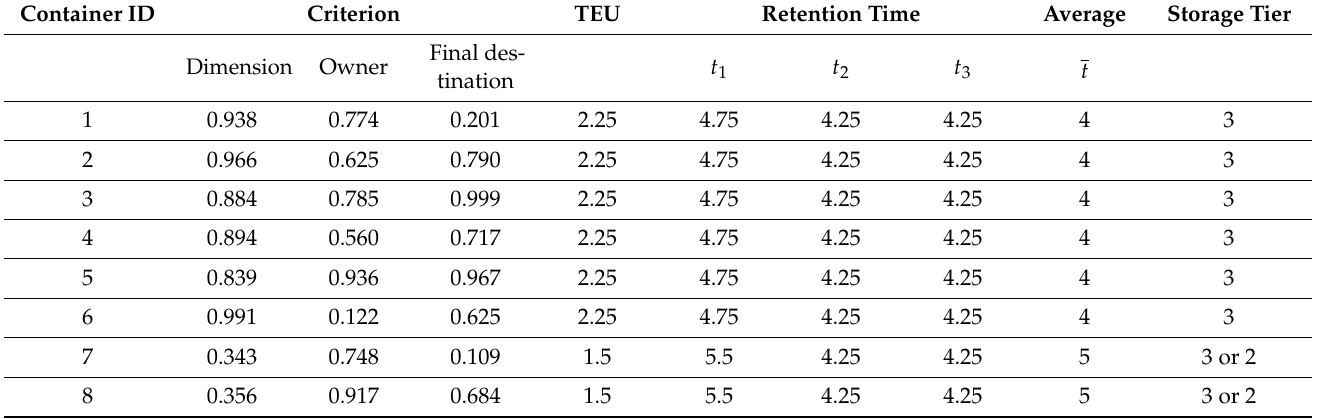
Table 15. Modeling the retention time and storage tier of inbound containers at the simulated inland